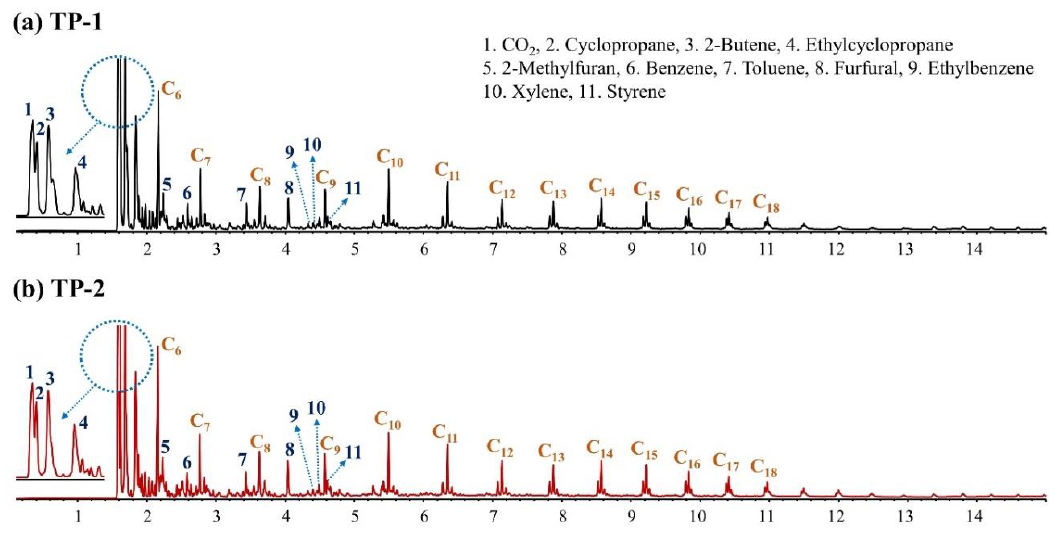
Figure 3. TICs obtained from non-catalytic Py-GC/MS analysis of ( a ) TP-1 and ( b ) TP-2 at 650 °C.